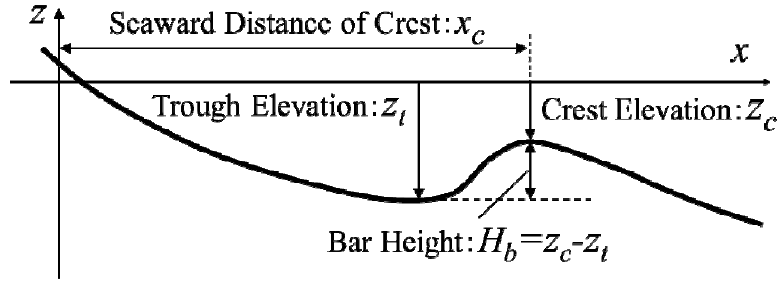
Figure 4. Definition of bar properties.